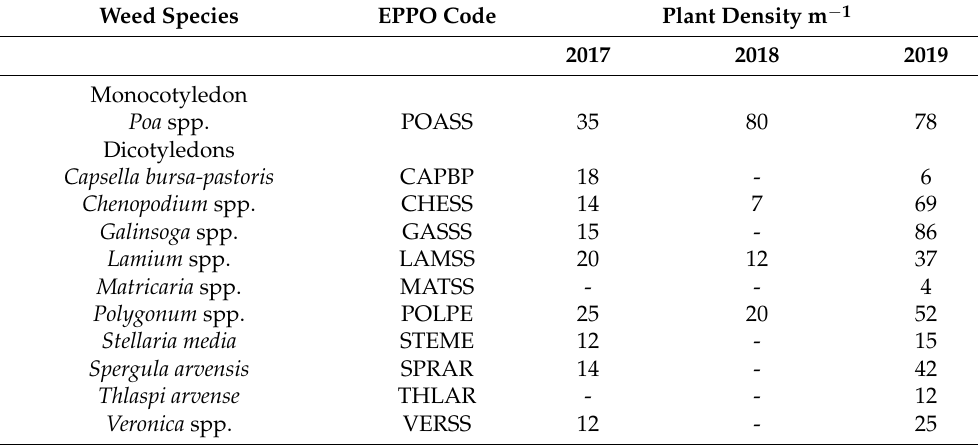
Table 5. Mean weed species density m − 1 per experimental year (2017 to 2019) recorded before the first weed control